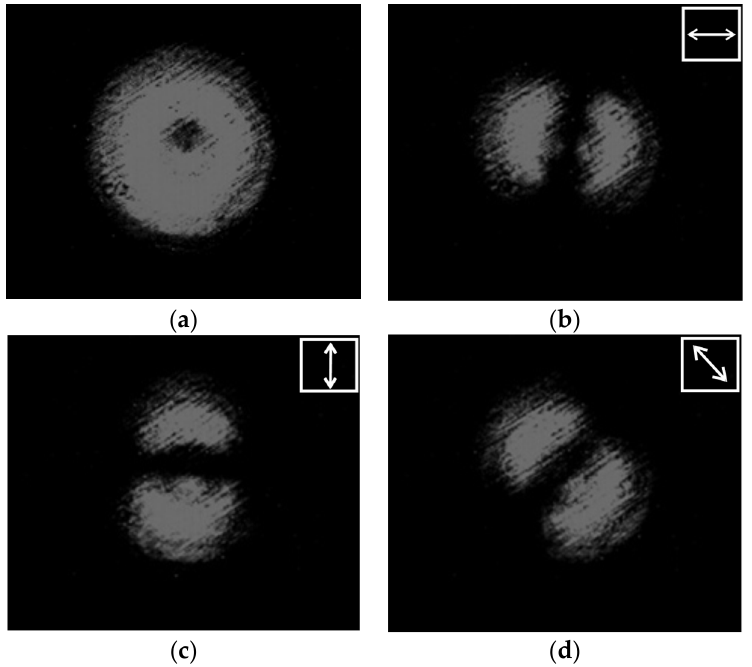
Figure 10. Intensity distributions of a radially polarized beam: ( a ) without a polarizer, and ( b – d ) with a polarizer for the axis inclined at ( b ) 0°, ( c ) 45°, and ( d ) 90°. One can see that the state of the beam polarization is close to the first-order radial plane polarization (in the absence of a Q-plate) and for azimuthal polarization (in the presence of a Q-plate).